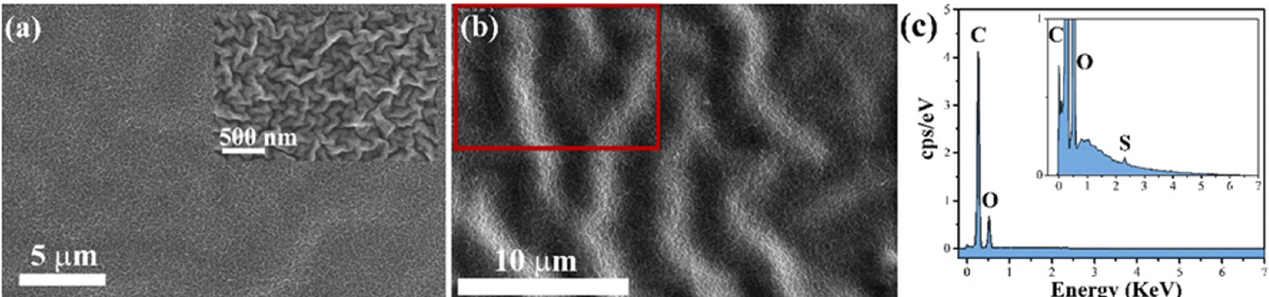
Figure 4. SEM images of acrylic binder surface (binder-A) non-loaded ZnO particles at ( a ) low magnification (inset: SEM images at high magnification); ( b ) BSE-SEM image of binder-A; ( c ) EDS spectra from the binder-A surface. The inset shows the EDS spectra focused on the Sulfur region. The red frame in the BSE-SEM image indicates the area of analysis.